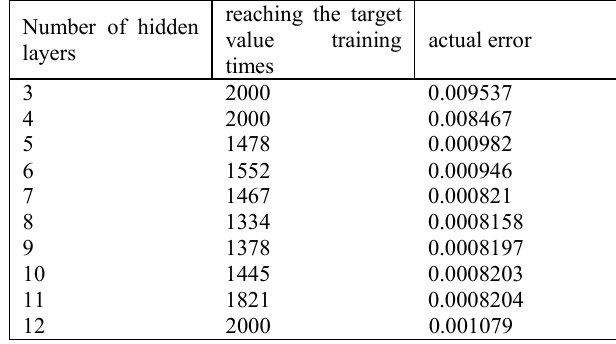
Table 4. Network training situation table with different number of hidden layer